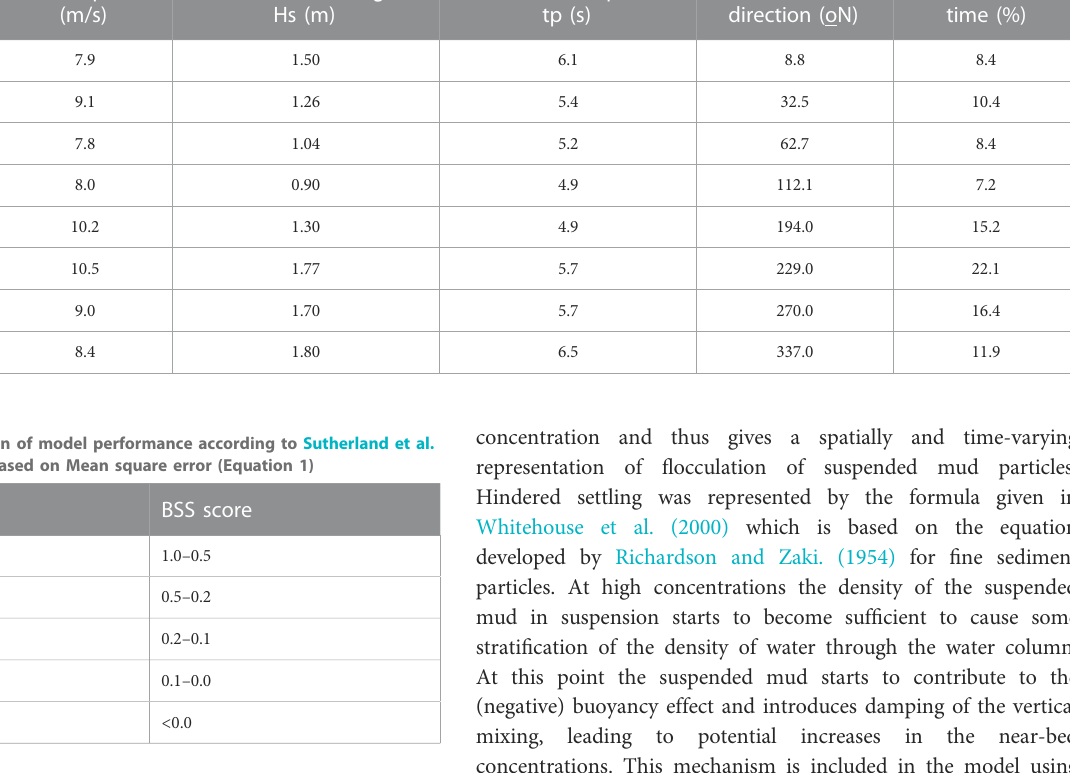
TABLE 2 Morphological wind and wave conditions. Direction (oN)